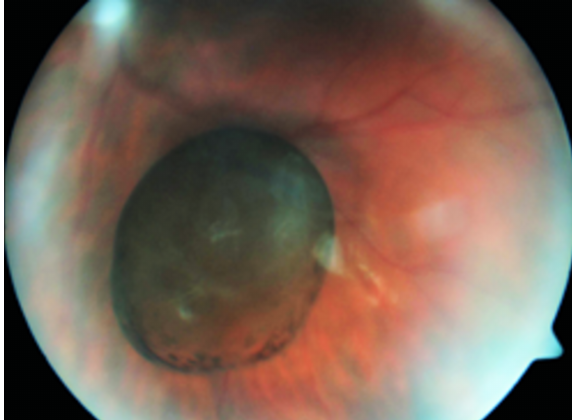
Figure 1: Fundus photograph showing the free-floating, pigmented vitreous cyst The diameter of the cyst had measured 2.8 mm four years earlier, as described by Missotten et al. [7]. The cyst was aspirated during a 27-gauge vitrectomy, and the cyst wall was extracted and histologically examined. Post- operatively, the patient regained a vision of LogMar